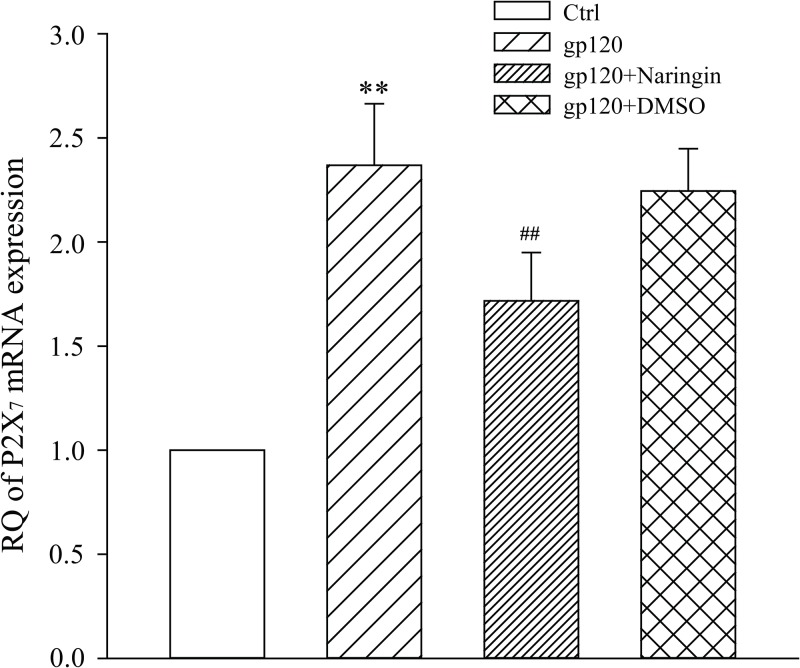
Expression of P2X7 mRNA in different treatment groups detected by qPCR.**P < 0.01, versus Ctrl group; ##P < 0.01, versus gp120 group; n = 5.